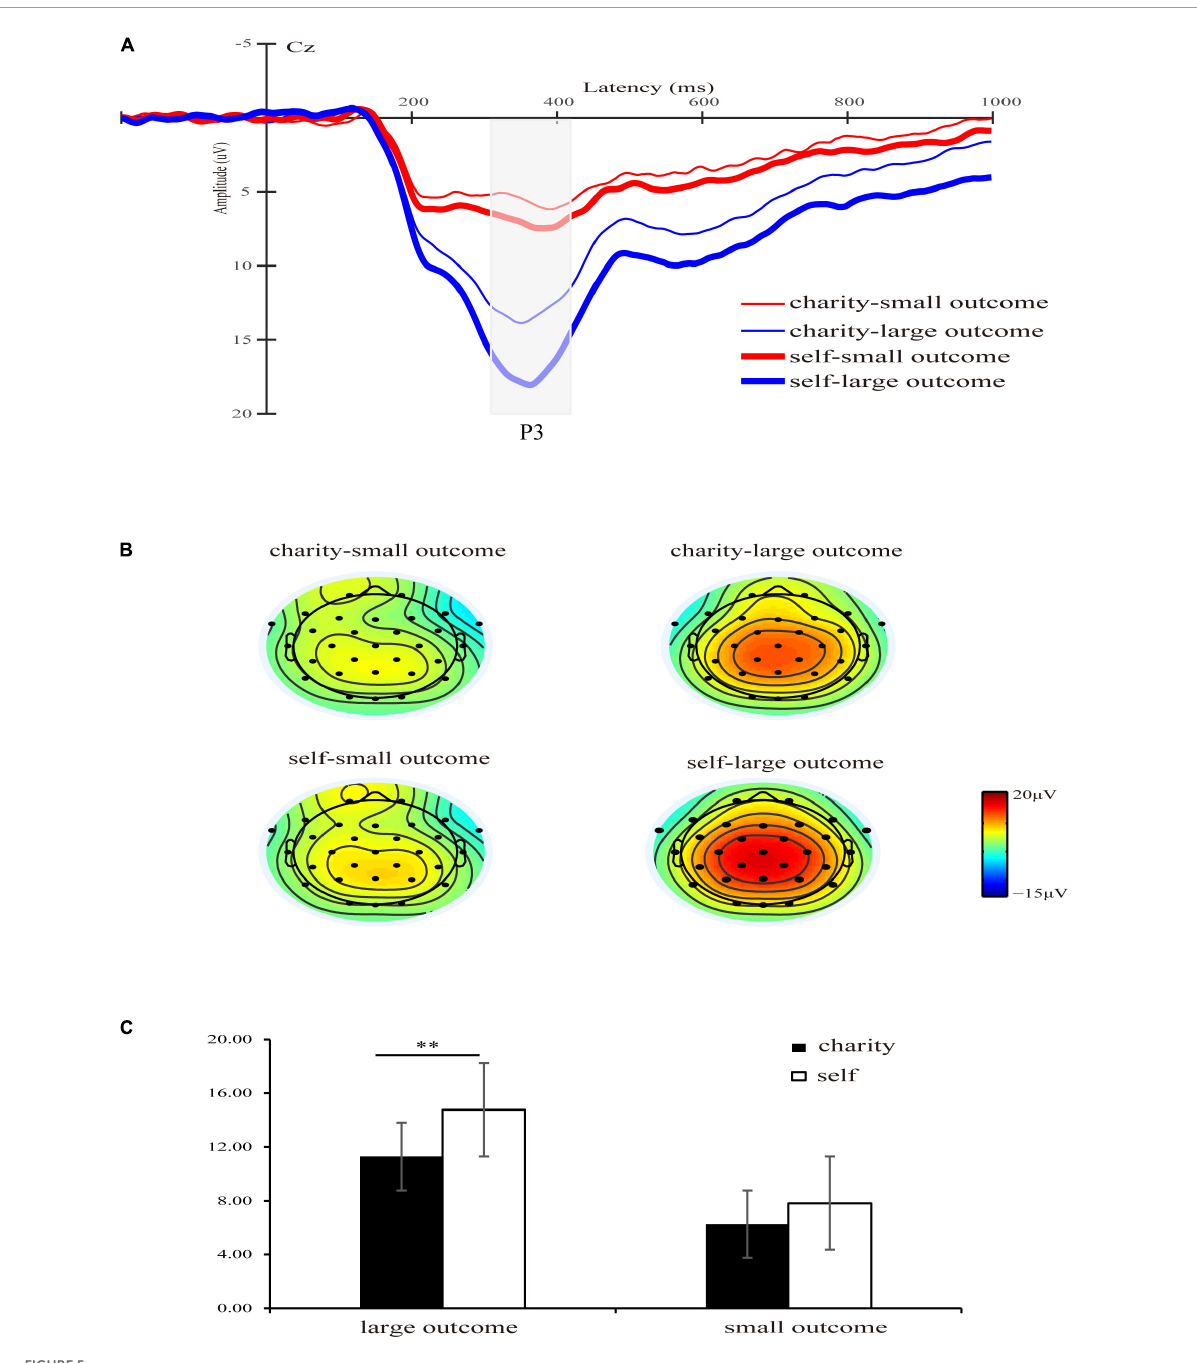
FIGURE5 (A) Grand-average ERP waveforms of P3 at Cz electrode site, the gray area highlights the 310–420 ms time window for calculating the mean value of the P3 amplitude. The thin red line represents the waveform with a charity-small outcome condition, the thin blue line represents the waveform with a charity-large outcome condition, the thick red line represents the waveform with a self-small outcome condition, and the thick blue line represents the waveform with a self-large outcome condition. (B) Topographic maps of P3 of each condition. (C) The bar graphs and standard errors show the mean values of P3 for each condition. ** p <